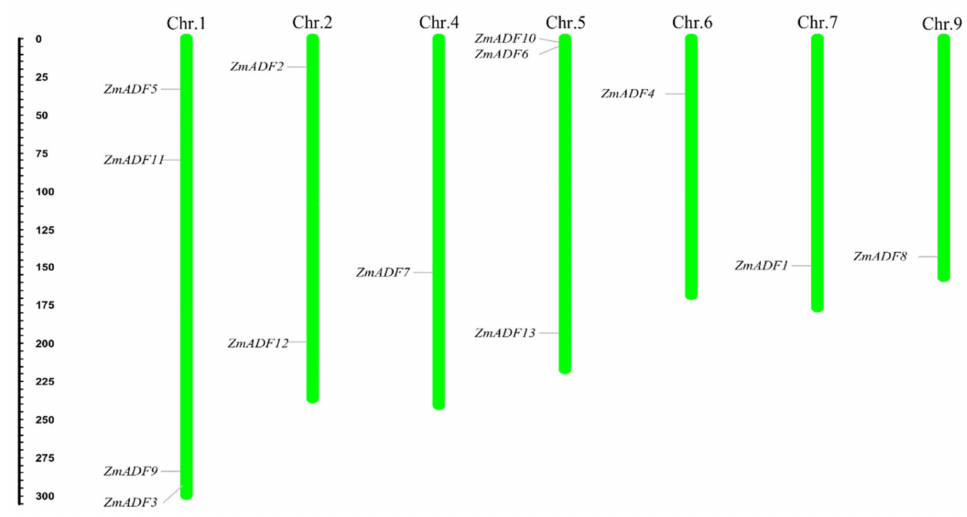
Figure 1. Chromosomal localization of maize ADFs. Thirteen ZmADF genes were distributed on chromosomes 1, 2, 4, 5, 6, 7, and 9. The chromosome numbers are indicated at the top of each vertical bar. Segmental duplication is the most import driving force for generating a gene family during the evolution process. In the present study, based on sequences identity and query coverage, ZmADF1 / ZmADF12 , ZmADF5 / ZmADF8 , ZmADF6 / ZmADF9, and ZmADF7 / ZmADF13 gene pairs were found to be segmentally duplicated (Figure 2), and were located on chromosomes 1, 2, 4, 5, 7, and 9. In contrast, none of the ADF genes in this study had tandem duplication.